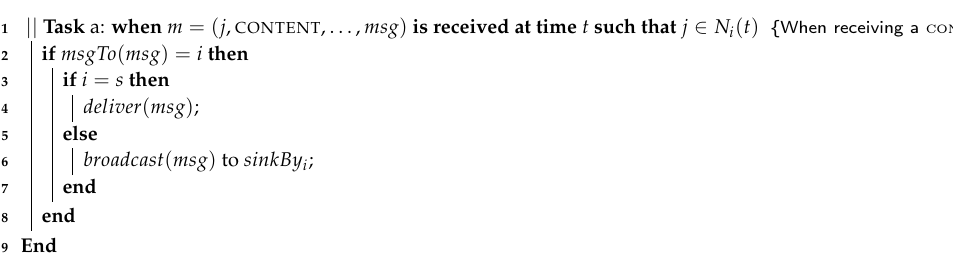
Algorithm 4: Direct forwarding strategy executed by node p i .